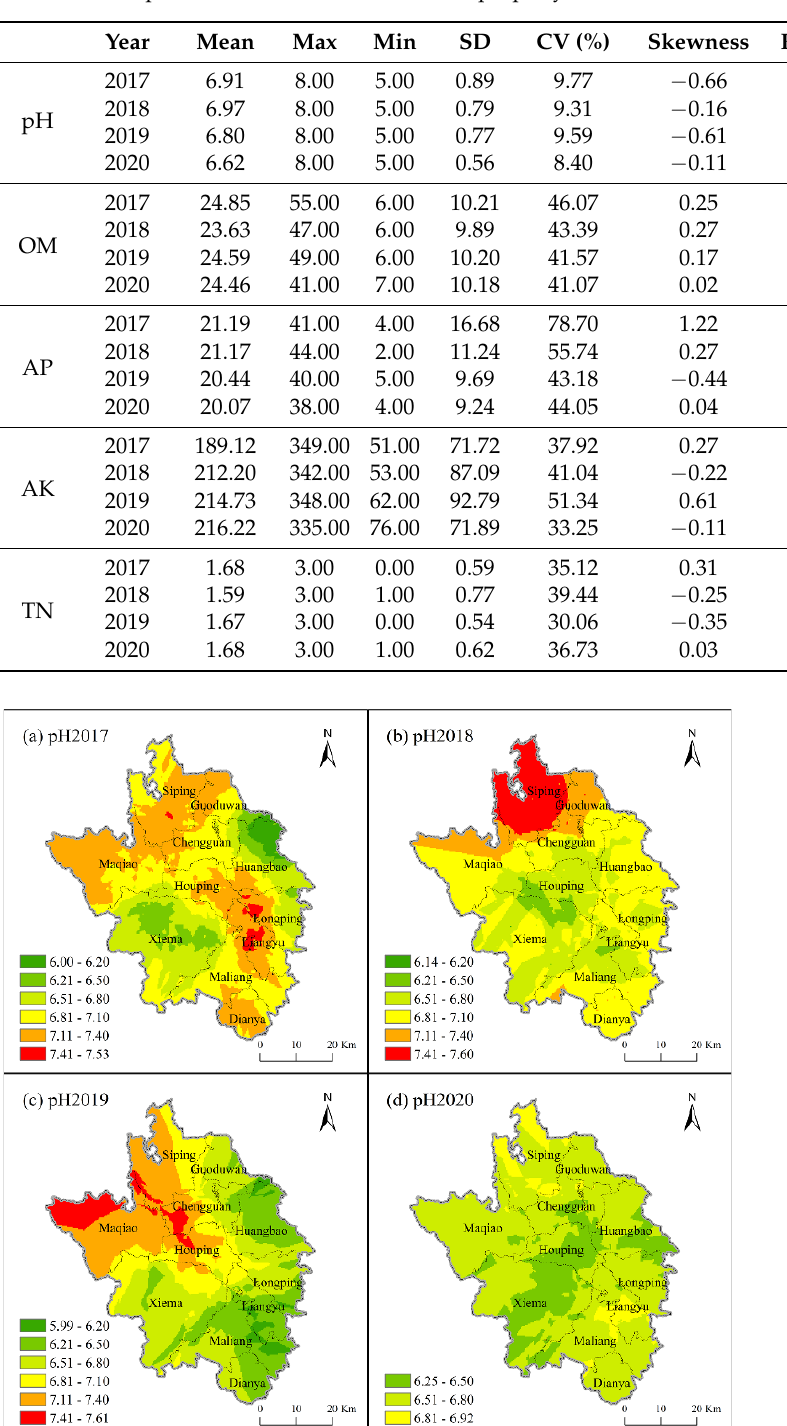
Figure 4. Ordinary kriging distribution maps for ( a ) 2017 pH, ( b ) 2018 pH, ( c ) 2019 pH and ( d ) 2020 pH.